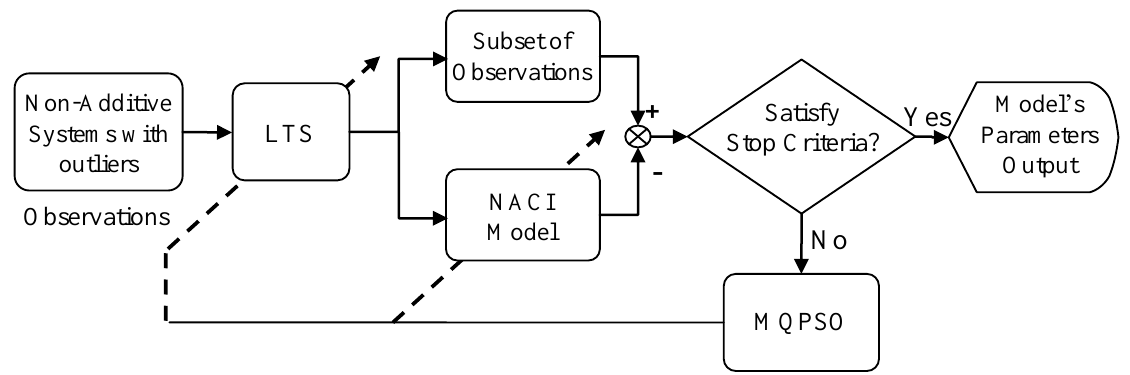
Figure 1. Block diagram of the proposed structure for the parameters estimation of the NACI model via MQPSO and LTS in the training state.